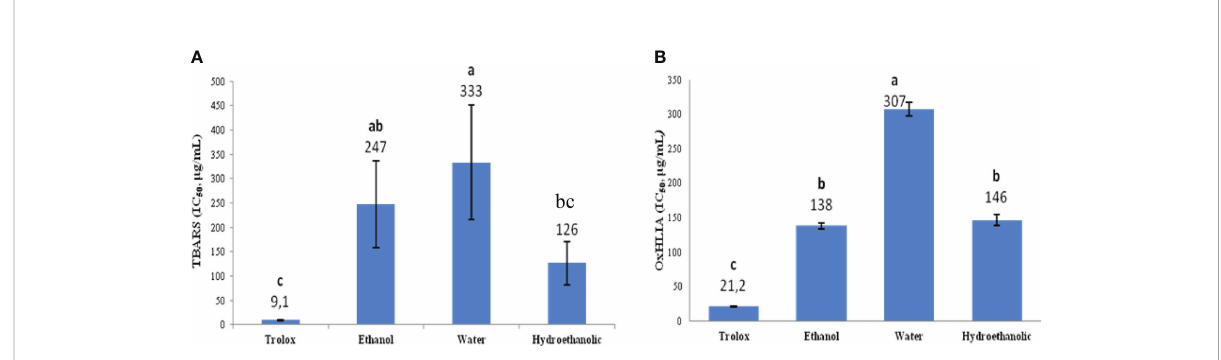
FIGURE 2 Ex vivo antioxidant activity ( A : TBARS, B : OxHLIA), of ethanol, water and hydroethanolic extracts of Limonium spathulatum . Values represent the mean ± SD of at least three repetitions (n = 3). For each assay bars marked with different letters are signi fi cantly different at p< 0.05 (Tukey HSD test).